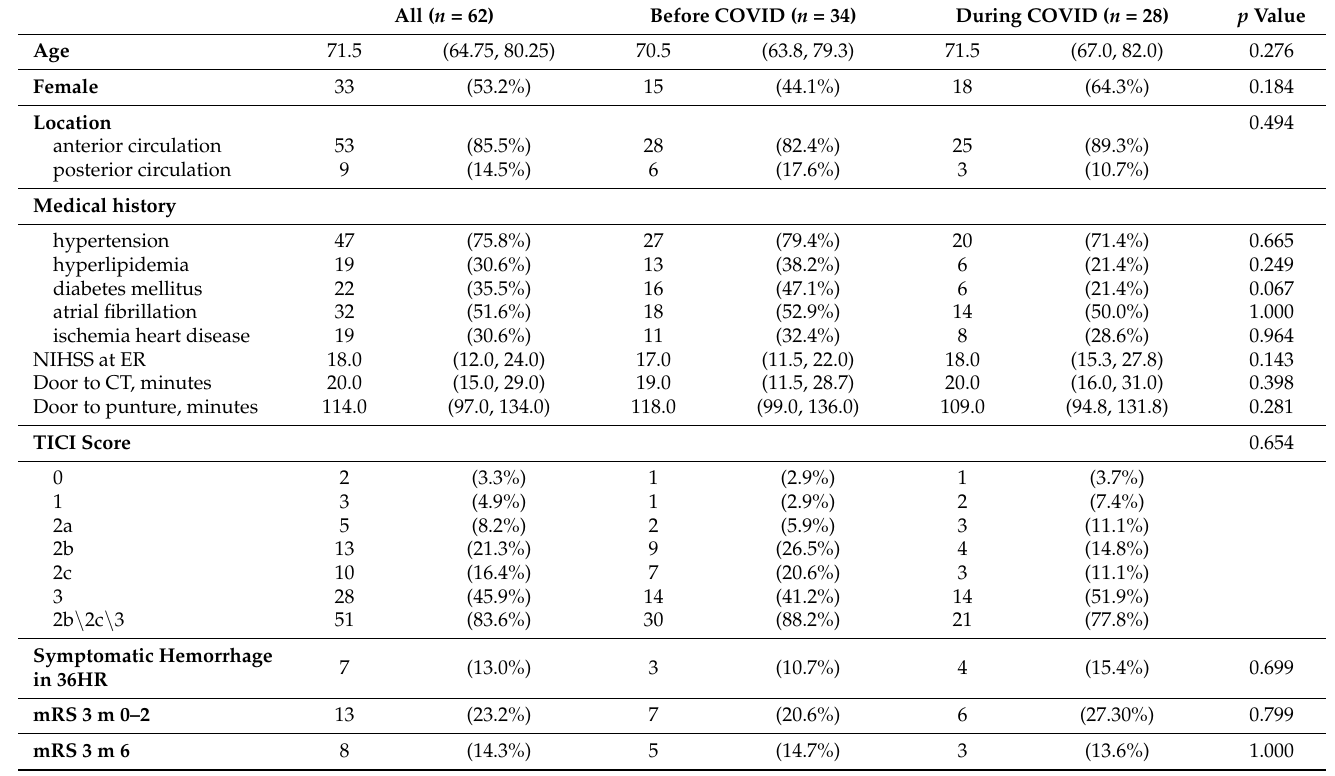
Table 1. The baseline characteristics and clinical outcomes of